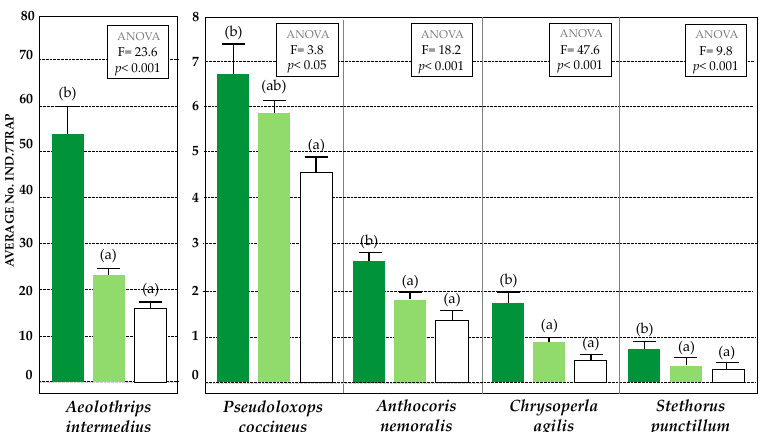
Figure 5. Statistical values (mean, SE) of the relative abundances of main predator species captured in the sticky yellow traps in the three agricultural managements: Conventional (white), VC olive grove (light green), and VC-MIX olive grove (dark green). Statistically significant differences are indicated by letters (Tukey’s HSD test, p < 0.05).